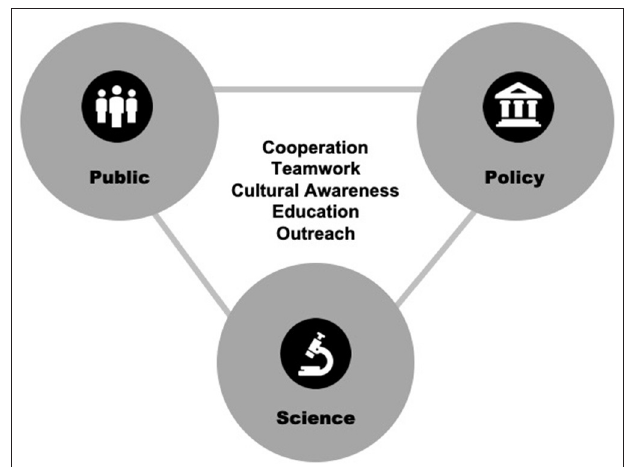
FIGURE 1 | Role of One Health practitioners. One Health practitioners in food safety and security bring together multidisciplinary teams consisting of experts from scientific, government, and public institutions to achieve meaningful change in public awareness, policies, and practices that support implementation of sustainable agricultural practices. It is the role of One Health practitioners to connect scientists, policy makers, and the public in dialog in order to realize meaningful change in agriculture practices and policies for the benefit of